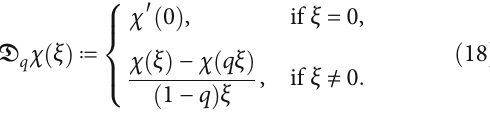
ξ Þ , if h ð ξ Þ = ξ + σ ð